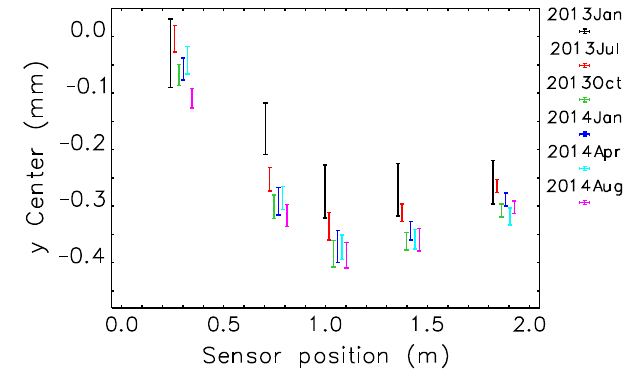
FIG. 15. Level of liquid helium in an internal tank over a 15-month period. Labels 1, 2, 3 are discussed in the text.